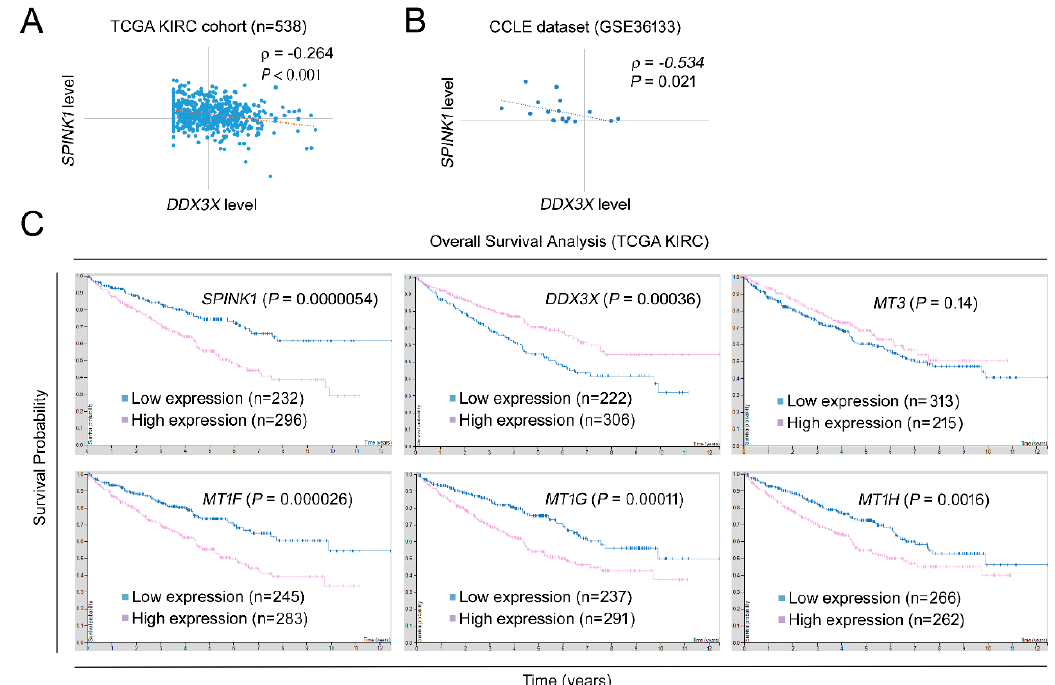
Figure 3. SPINK1 and the metallothionein gene family serve as prognostic indicators that reversely correlate with DDX3X in RCC. ( A ) The Pearson correlations of DDX3X and SPINK1 in the RCC cohort ( A ) and the CCLE dataset (GSE36133) ( B ) were evaluated. ( C ) The prognostic significance of gene targets from the SPINK1 pathway is shown. The prognostic power of overall survival was evaluated based on the mRNA expression level of the indicated targets in the TCGA RCC cohort. The data were retrieved from The Pathology Atlas (https://www.proteinatlas.org/) (access on Mar. 9 th , 2020).